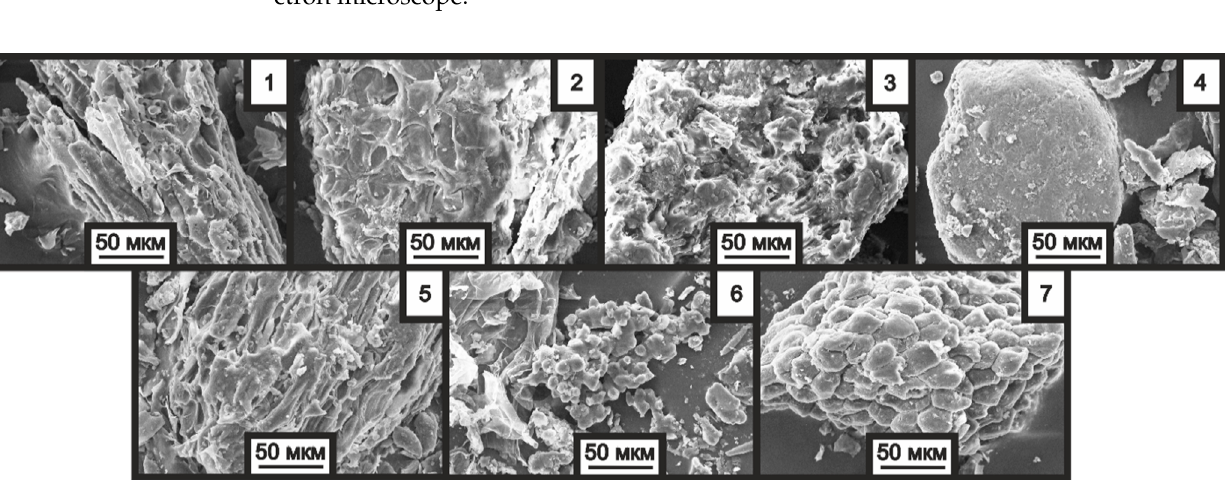
Table 1. Physicochemical characteristics of the nut shell samples.